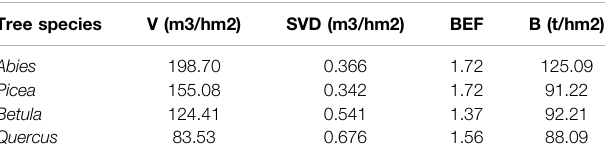
TABLE 3 | Biomasses of Abies , Picea , Quercus , and Betula per unit area. Tree